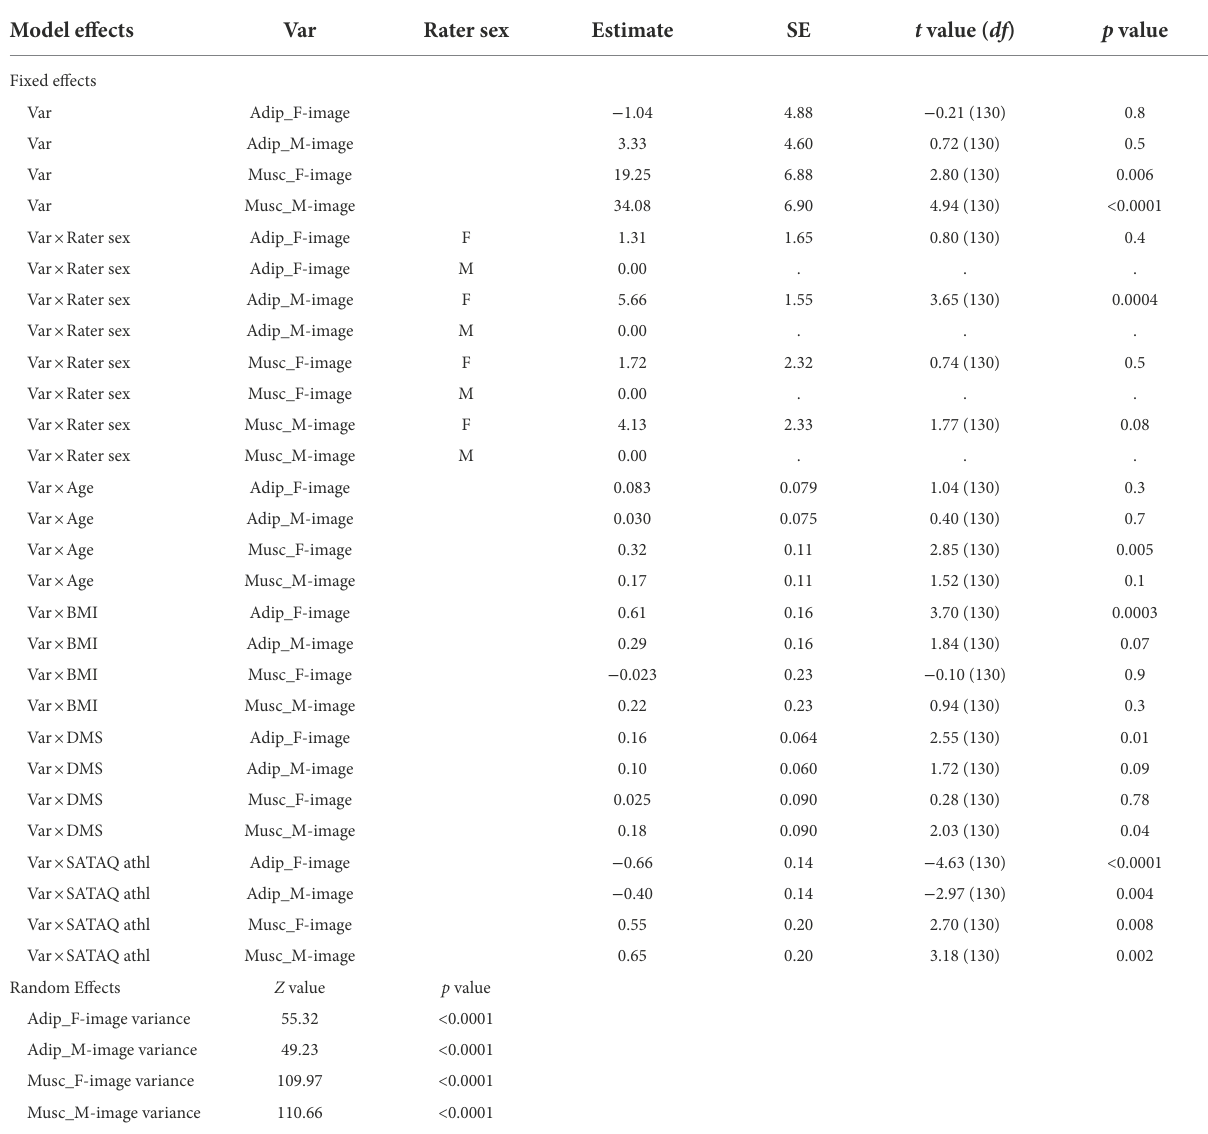
TABLE 5 Multivariate multiple